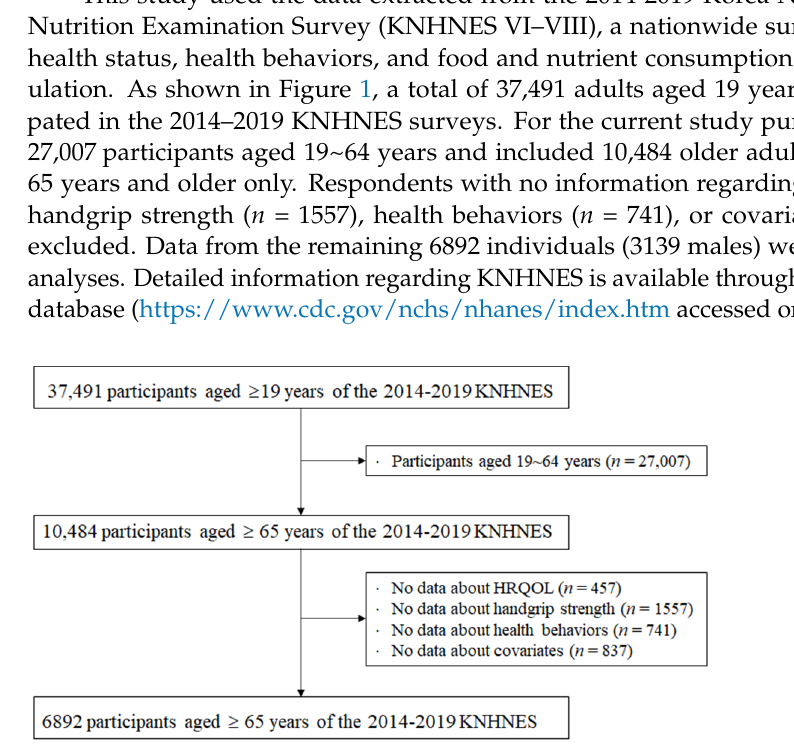
Figure 1. Flowchart for the selection of study participants. KNHNES: Korea National. Health and Nutritional Examination Survey; HRQOL: health-related quality of